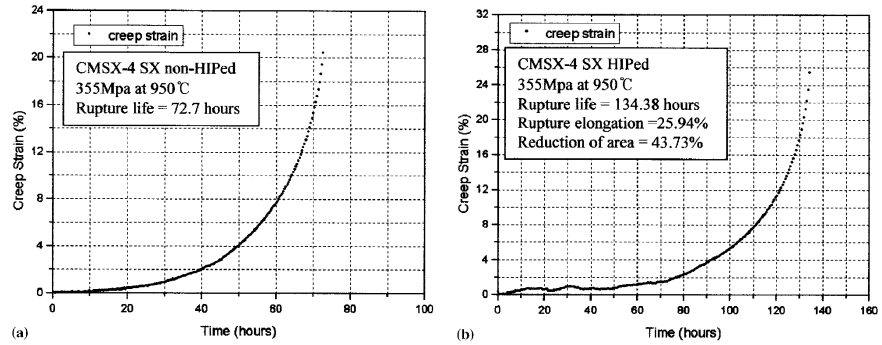
Figure 16. Stress-rupture curves of ( a ) non-HIP treated and ( b ) HIP treated [33] .